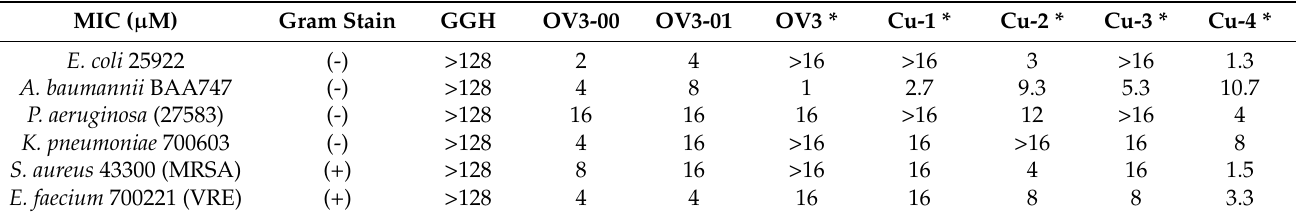
Table 2. MIC Values ( µ M) for SMAP-29 Derivatives. * Previously reported data from reference [8] r